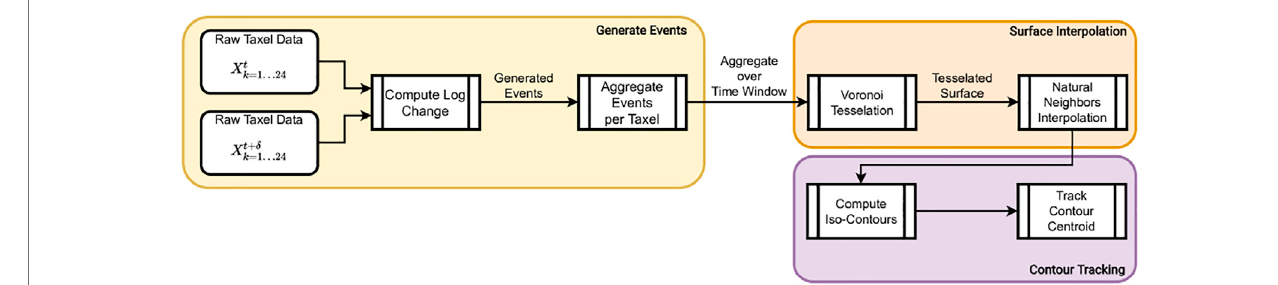
FIGURE 1 | High-level organization of our pipeline.